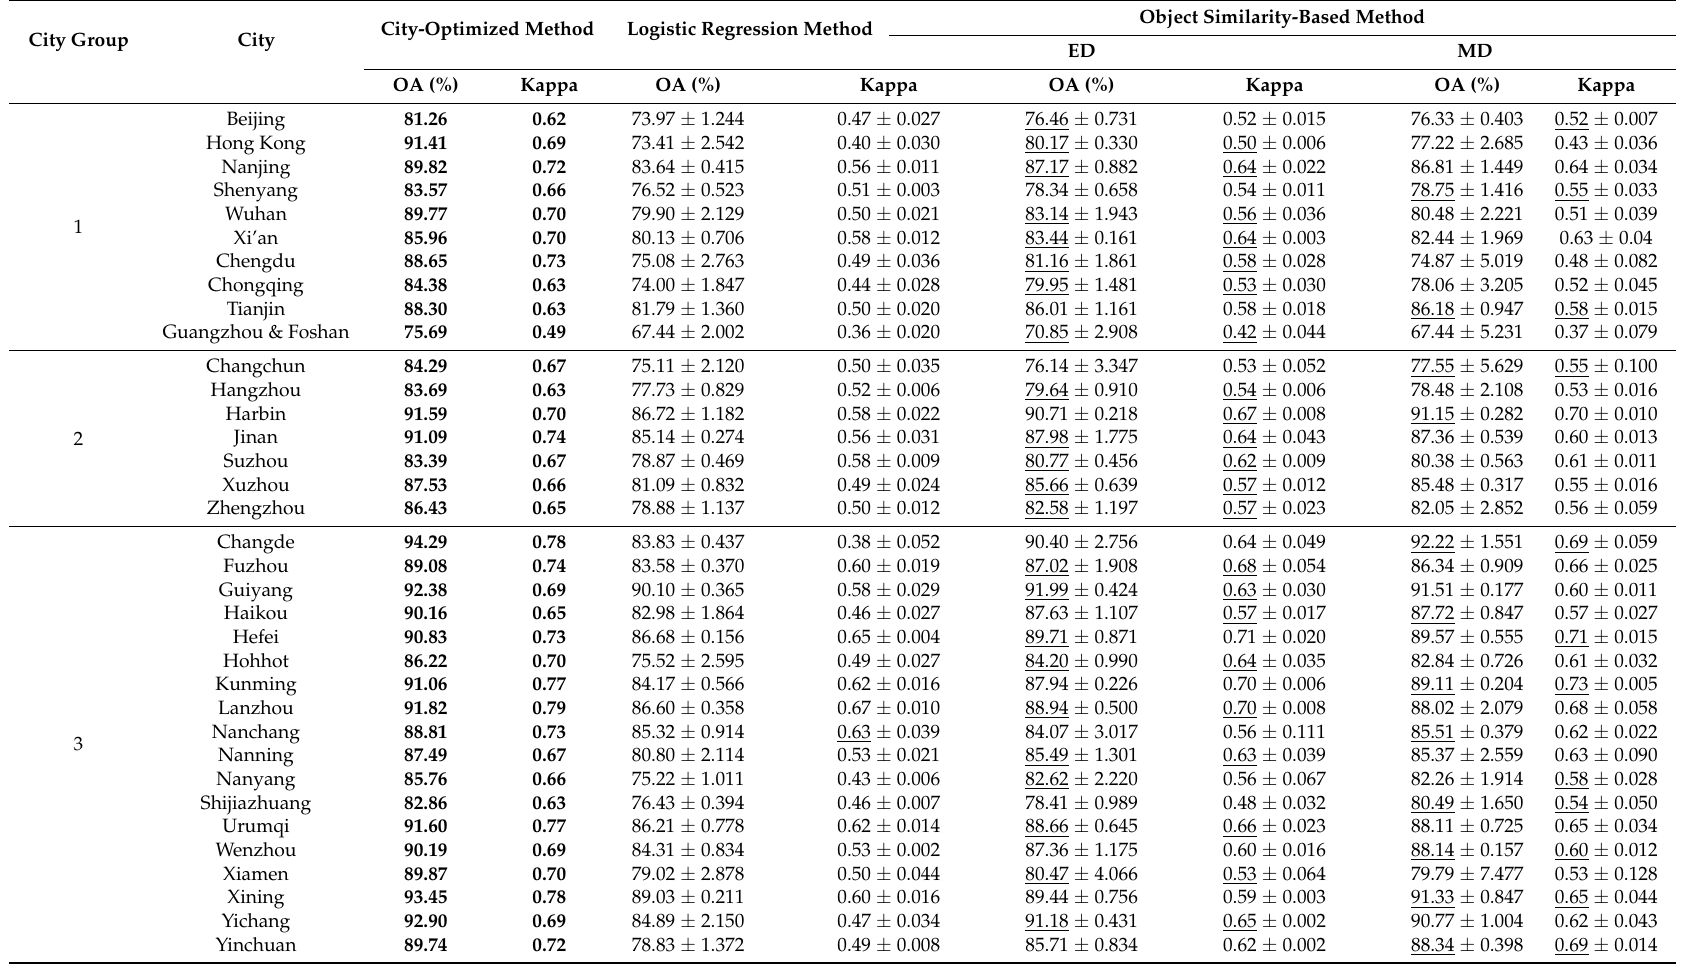
Table 2. Overall accuracies and Kappa Coefficients of the urban area mapping results for reference cities from different methods in five tests. Logistic Regression City Group City